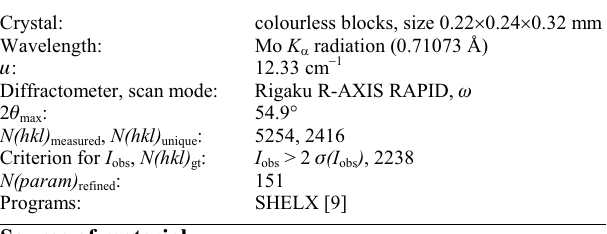
Table 1. Data collection and handling.